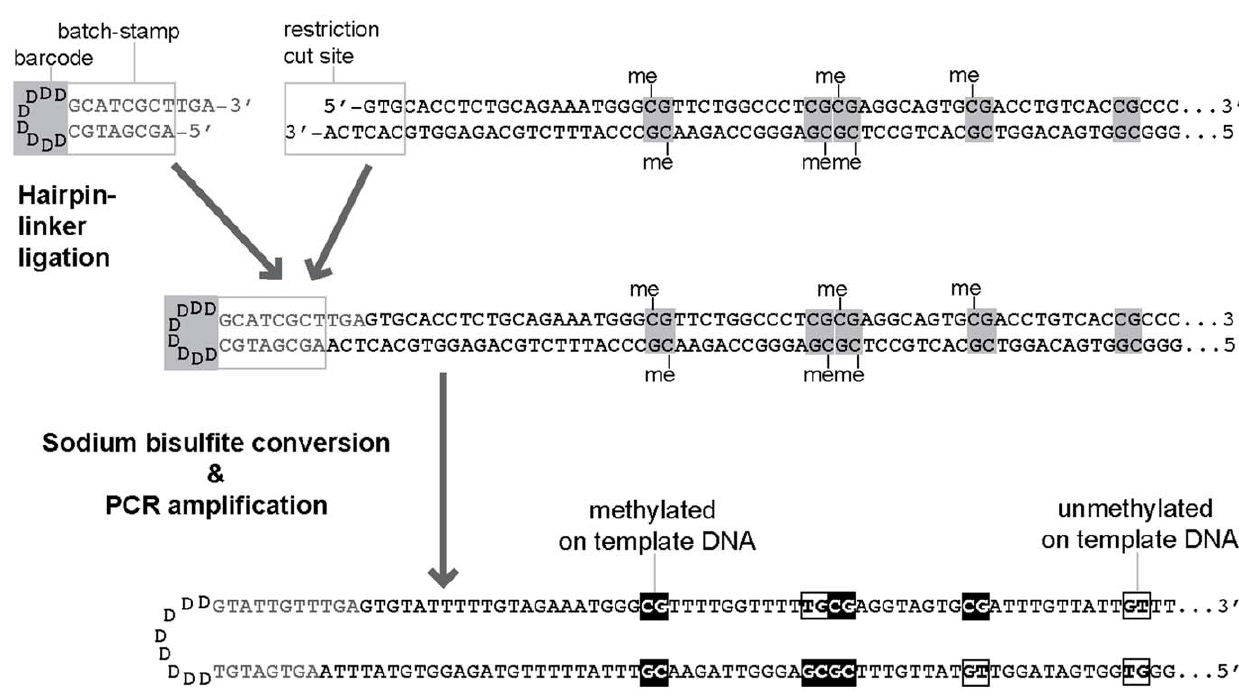
Figure 2. Hairpin–bisulfite PCR at FMR1 (after Miner et al. [ 20 ] ). The genomic sequence from both strands of the FMR1 promoter, including the first five of the analyzed analyzed CpG sites, is shown. A hairpin linker, here illustrated for hairpin I, is ligated to both strands of an individual DNA molecule prior to bisulfite conversion and PCR amplification. The bisulfite-conversion reaction converts cytosine, but not 5-methylcytosine (‘‘me’’), to uracil, thus preserving information on methylation patterns in genomic DNA. After PCR amplification, uracil residues will appear as thymine; a cytosine detected in the sequence of a PCR product therefore indicates methylation of that base in the genomic DNA.